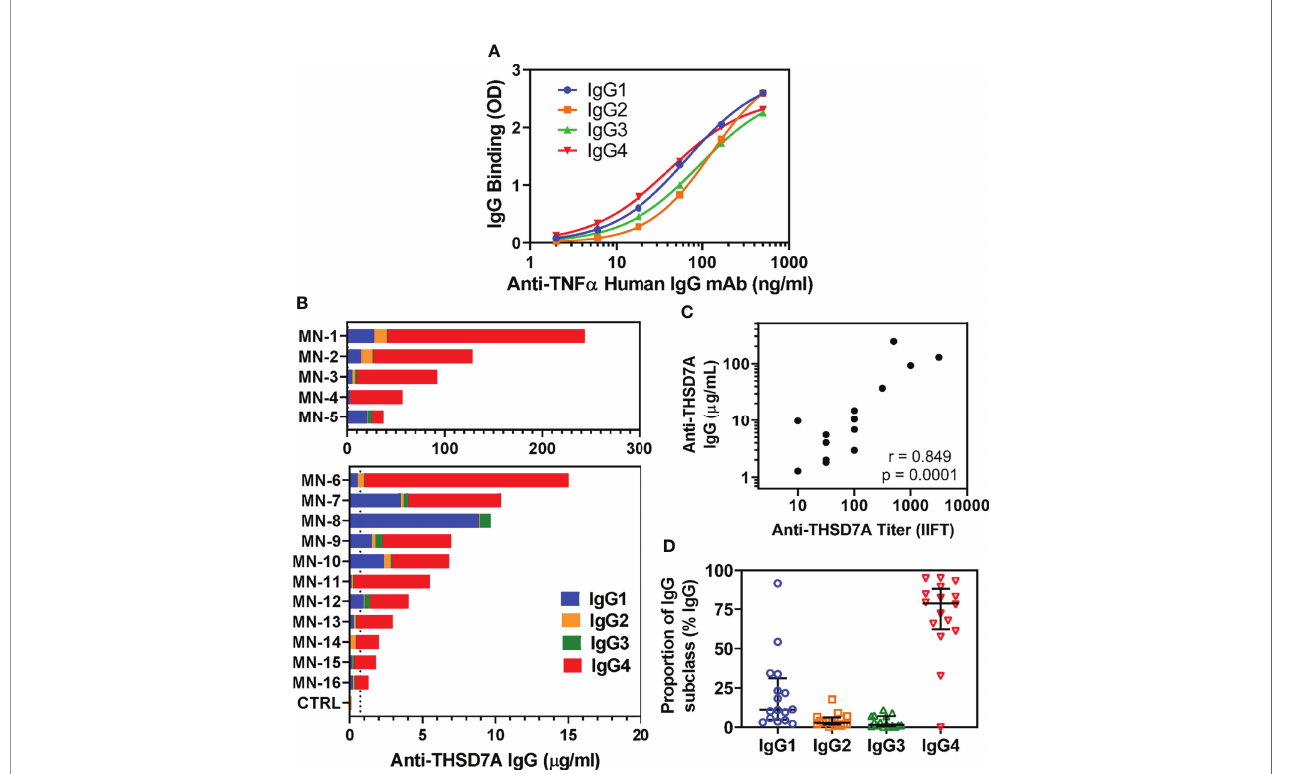
FIGURE 1 | Analysis of IgG subclasses of anti-THSD7A autoAbs. (A) Standard curves show the concentration dependence for the binding of recombinant human anti-TNF a IgG1 (blue), IgG2 (orange), IgG3 (green) and IgG4 (red) to wells coated with TNF a antigen. (B) Sera from 16 patients with THSD7A-associated MN were analyzed by ELISA for IgG autoAb subclasses binding to immobilized THSD7A. The serum concentrations of anti-THSD7A IgG1 (blue), IgG2 (orange), IgG3 (green) and IgG4 (red) in each MN serum were interpolated from standard curves using recombinant human IgG1-IgG4 mAbs anti-TNF a . Sera were designated MN-1 to MN-16 in decreasing order of their levels of anti-THSD7A IgG, calculated as the sum of the concentrations of all four IgG subclasses. (C) The correlation between serum levels of anti-THSD7A IgG measured by ELISA and the anti-THSD7A titers measured by indirect immuno fl uorescence test (IIFT) was signi fi cant (Pearson r=0.849, p=0.0001). (D) The relative proportion of IgG subclasses in MN sera was calculated by dividing the serum concentration of each subclass to sum of concentrations for all four IgG subclasses of autoAbs. The error bars show the median and the interquartile range.